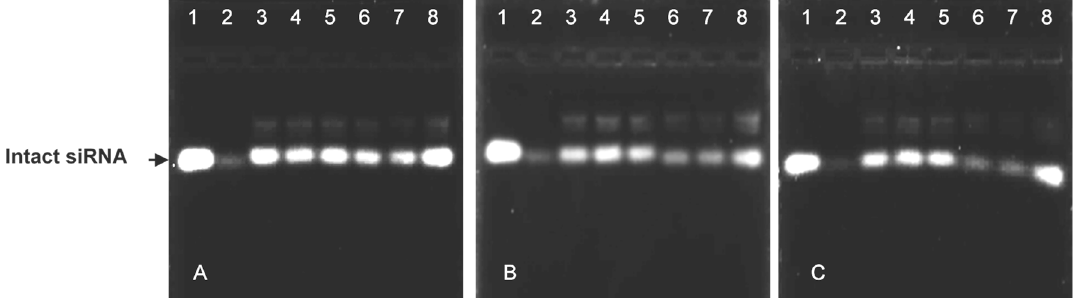
Figure 3. Nuclease protection assay of cationic and PEGylated cationic liposome-siRNA complexes in the presence of 10% FBS. Reaction mixtures (10 µL) contained siRNA (0.2 µg) and varying amounts of liposome suspension. ( A ) Lanes 3–5: Chol-T (2.4, 2.8, 3.2 µ g) Lanes 6–8: MS09 (3.8, 4.2, 4.6 µ